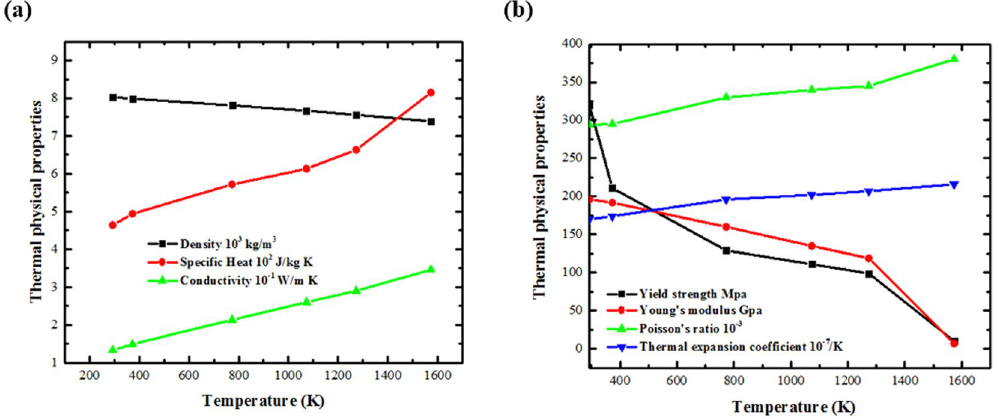
Figure 3. Temperature-dependent ( a ) thermal-physical properties and ( b ) thermal-mechanical properties of AISI 316 stainless steel.